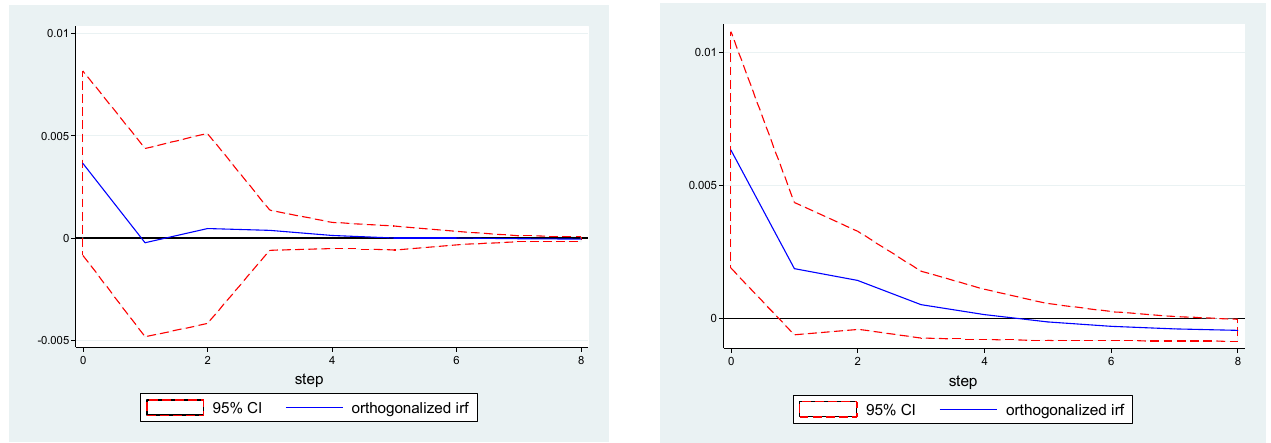
Figure 1. Impulse Response Function of Shortcapital to Expect and lnCurrency.